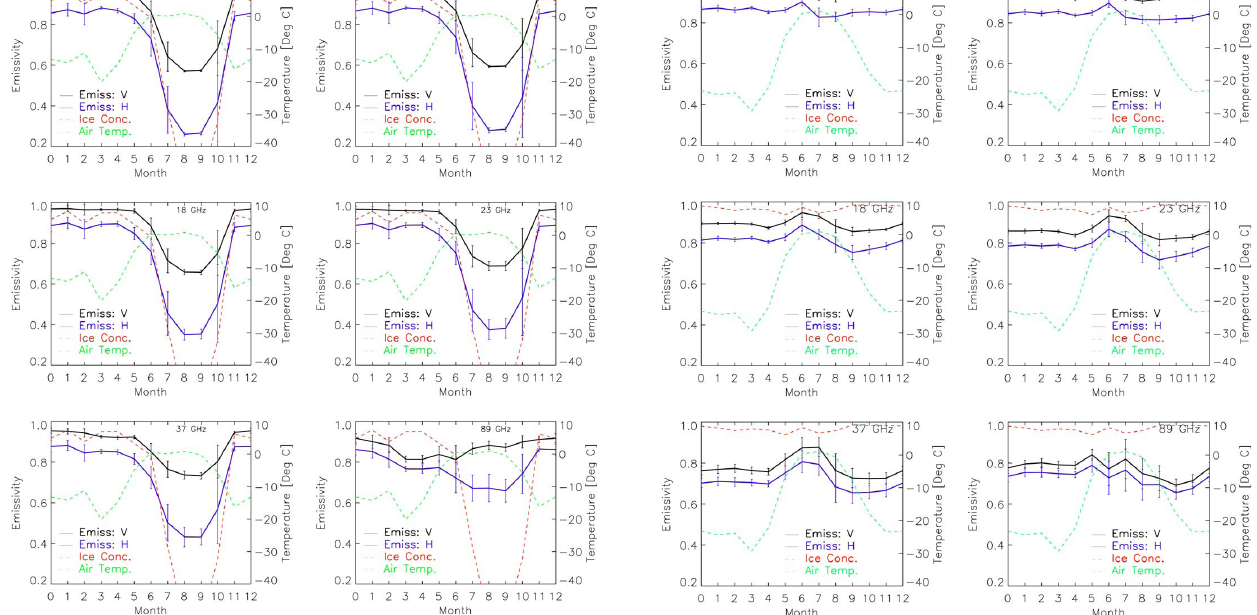
Figure 2. Seasonal variation of emissivities of multiyear ice at AMSR-E frequencies [(black) vertical Fig. 2. Seasonal variation of emissivities of multi-year ice at and (blue) horizontal polarizations]. (Top left) 7 GHz, 10 GHz, 18 GHz, 23 GHz, 37 GHz, and (bottom AMSR-E frequencies [(black) vertical and (blue) horizontal polar- right) 89 GHz. Red dashed line: Ice concentration. Green dashed line: Air temperature. Months 0 and 12 are the same. From Mathew et al. (2009). izations]. (Top left) 7, 10, 18, 23, 37 and (bottom right) 89GHz. Red dashed line: ice concentration; green dashed line: air temperature. Months 0 and 12 are the same from Mathew et al.